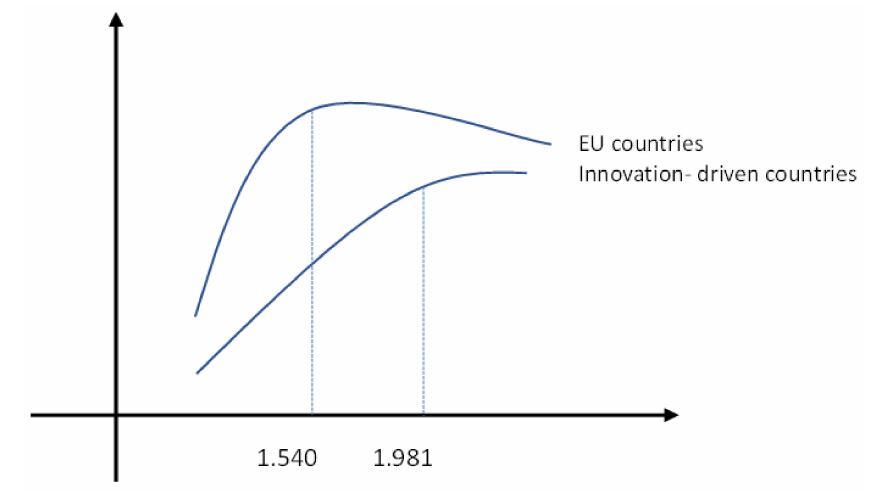
Figure 2. Overall outcomes. Source: authors’ own